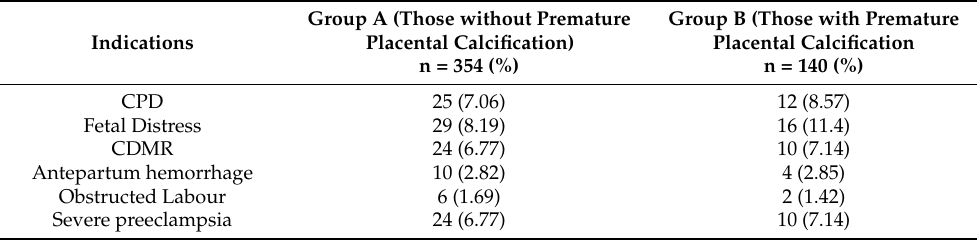
Table 5. Indications of